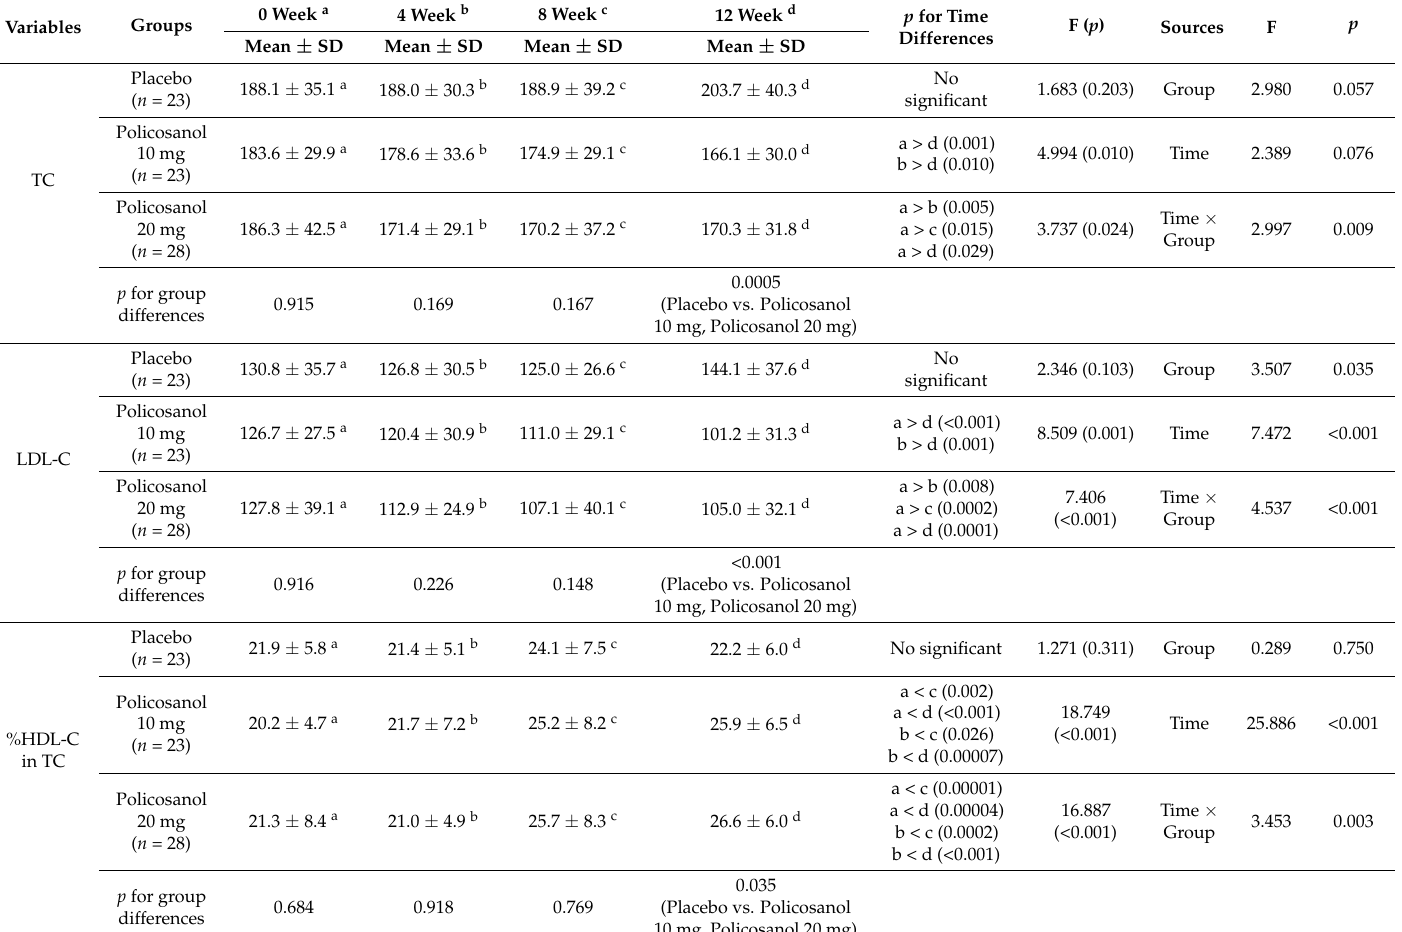
Table 5. Repeated measures ANOVA of serum TC, LDL-C, and %HDL-C profile between the three